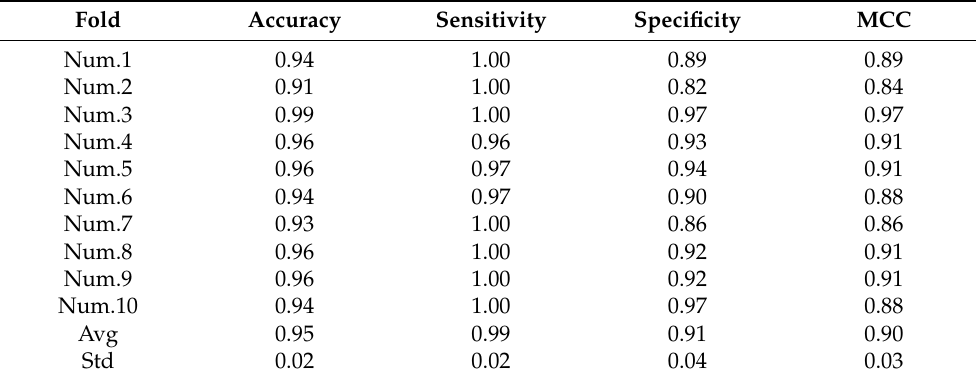
Table 7. Classification results obtained for RCCBOA-SVM-FS with four metrics. Fold Accuracy Sensitivity Specificity